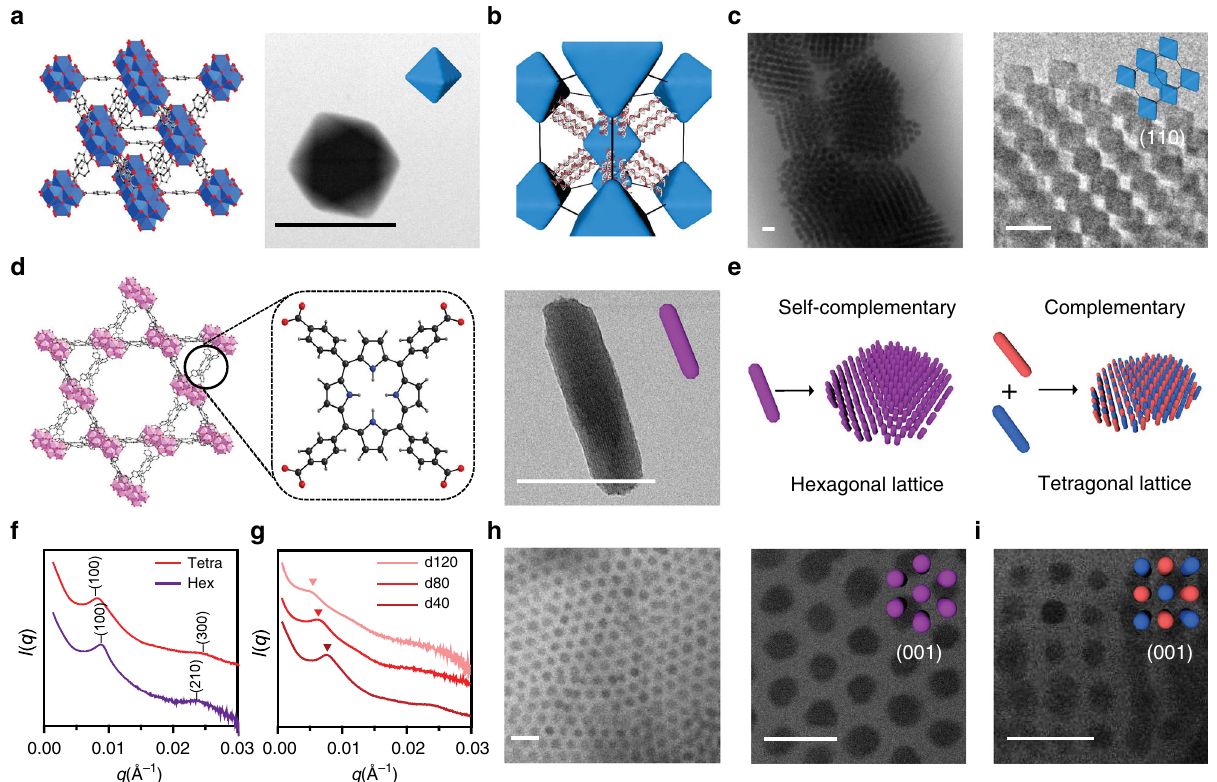
Fig. 4 Shape-dependent MOF superlattice assemblies. a Crystal structure and bright fi eld (BF) STEM image of an octahedral UiO-66 NP formed by Zr 6 SBUs and terephthalic acid ligands. b A model of a bcc lattice formed with face-to-face oriented UiO-66 PAEs, as such arrangement maximizes DNA hybridization interactions. c Cryo-STEM BF images show that octahedral-shaped UiO-66 PAEs with self-complementary DNA linkers assemble into bcc lattices. d Crystal structure and BF STEM image of a single PCN-222 nanorod formed by the connection of Zr 6 SBUs and tetrakis(4-carboxyphenyl) porphyrin linkers (box). e Schematic representation of PCN-222 PAEs assembled into two different lattices depending on DNA link design: nanorods functionalized with self-complementary DNA linkers (purple) form a 2D hexagonal superlattice (left), and complementary DNA linkers (red and blue rods) assemble into a 2D tetragonal superlattice (right). f 1D SAXS patterns of PCN-222 superlattices with in-plane hexagonal (purple) and tetragonal (red) symmetries. g 1D SAXS patterns of PCN-222 tetragonal superlattices with tunable interparticle spacings by changing DNA linker lengths [d40: 77 nm (crimson), d80: 92 nm (red), d120: 109 nm (pink)]. h Cryo-STEM BF images show that PCN-222 PAEs with self-complementary DNA linkers close-pack into 2D hexagonal lattices. i Cryo-STEM BF image shows that PCN-222 PAEs interconnected by complementary DNA linkers form a 2D tetragonal lattice. All scale bars are 100